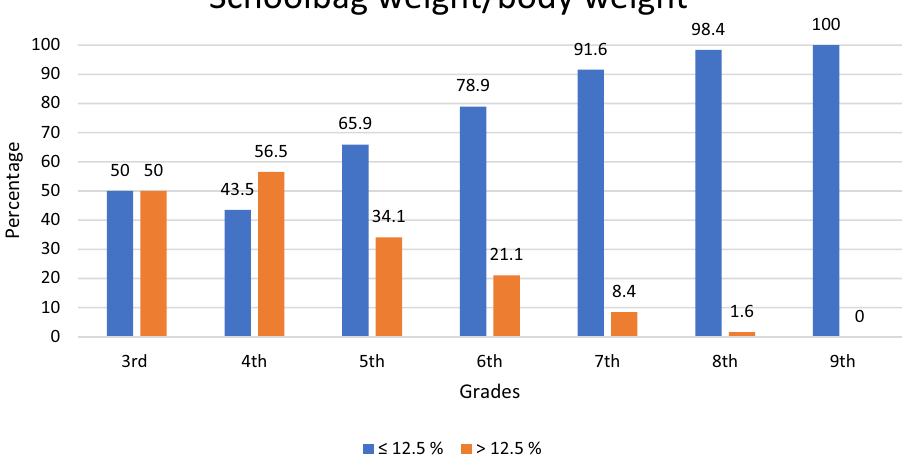
Figure 2. Prevalence of students carrying school bags up to 12.5% and more than 12.5% of body weight.